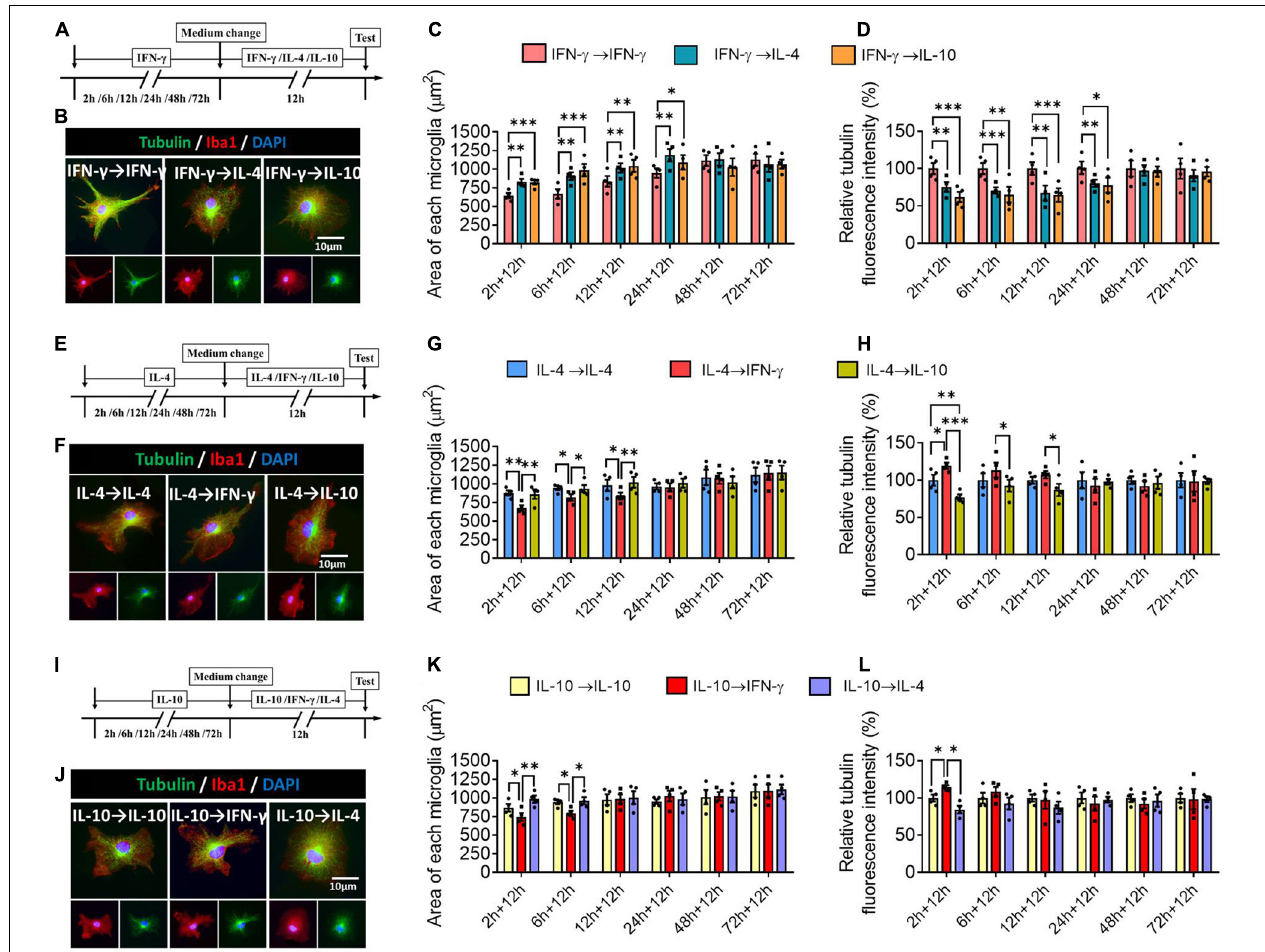
FIGURE 9 | Plasticity of microglial phenotypes based on morphology. (A–D) Plasticity of morphology of IFN- γ -treated microglia in different response state following IL-4 or IL-10 exposure for 12 h. (A) Experimental scheme of IFN- γ -stimulated microglia at 2, 4, 6, 12, 24, 48, and 72 h following IL-4 or IL-10 exposure. Same steps as Figure 8A . (B) Fluorescence micrographs of microglial cytoskeleton changes after cells were switched from the primary IFN- γ stimulation to secondary stimulation with IL-4 or IL-10 lasting 12 h. Cells were immunostained against tubulin (green) and Iba1 (red). (C) Quantification of the area in microglia initially stimulated with IFN- γ , then stimulated with another cytokine. (D) The changes in relative tubulin fluoresce intensity in microglia initially stimulated with IFN- γ , then stimulated with another cytokine. (E–H) Plasticity of morphology of IL-4-treated microglia in different response state following IFN- γ or IL-10 exposure for 12 h. (I–L) Plasticity of morphology of IL-10-treated microglia in different response state following IFN- γ or IL-4 exposure for 12 h. Five 40 × photographs were taken from each well, and all the cells in the field were measured. Data are presented as the mean ± SEM. n = 4 well per group, ∗ P < 0.05, ∗∗ P < 0.01, ∗∗∗ P < 0.005 (one-way ANOVA with Tukey’s multiple-comparisons